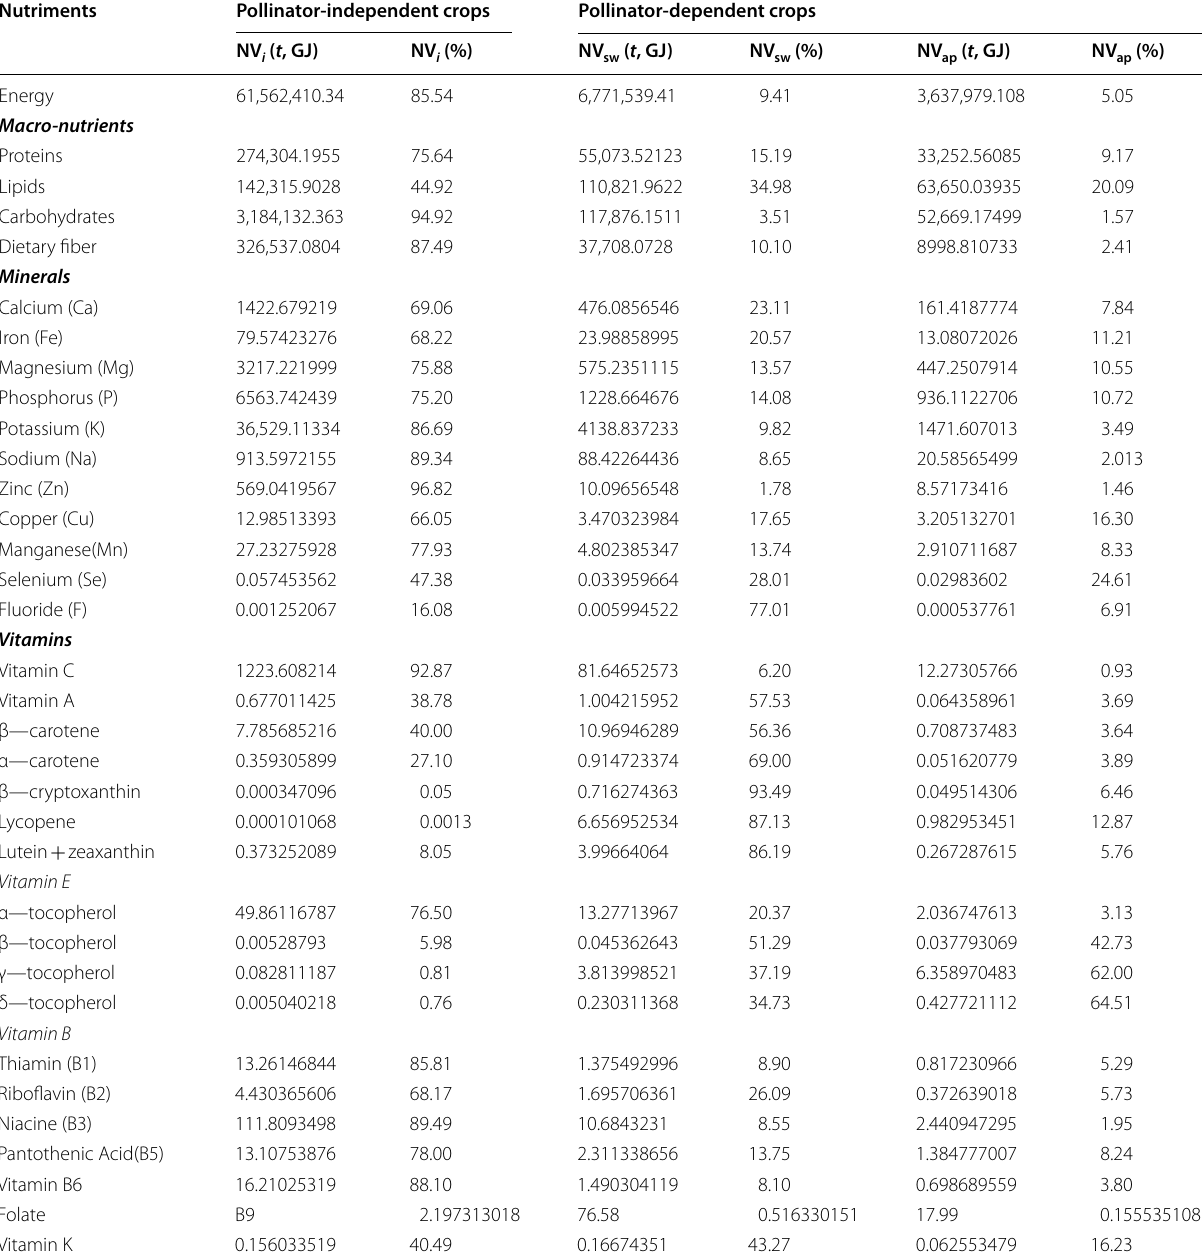
Table 2 Amount and percentage of nutrients obtained from pollinator-independent crops and pollinator-dependent crops